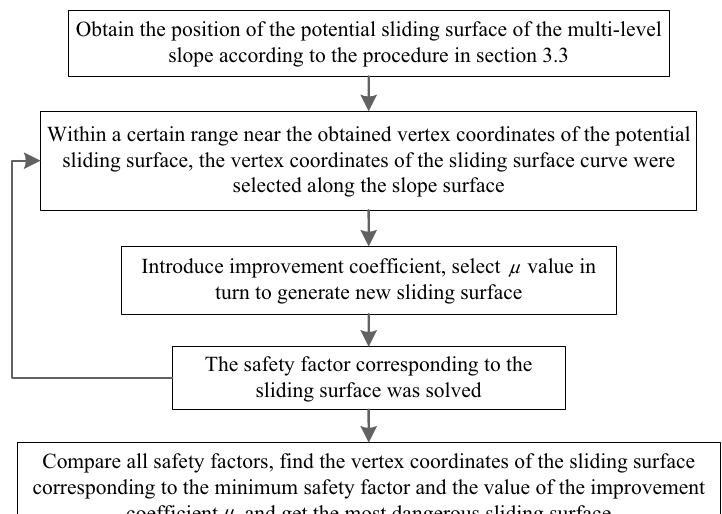
Figure. 6. Flowchart of the improved sliding surface